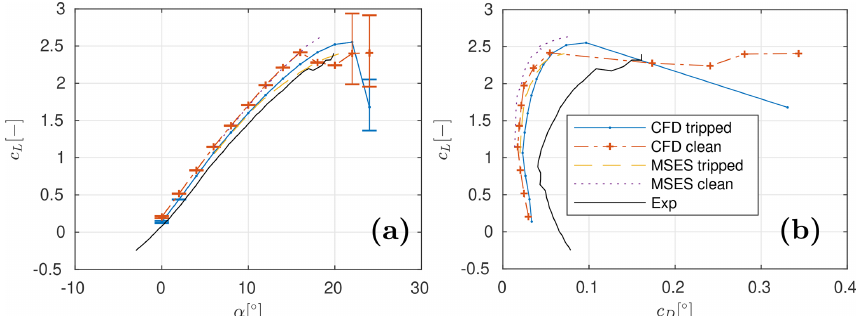
Figure 3. Fluid model validation against the benchmark case from Pechlivanoglou and Eisele (2014) for (a) the lift polar and (b) the drag